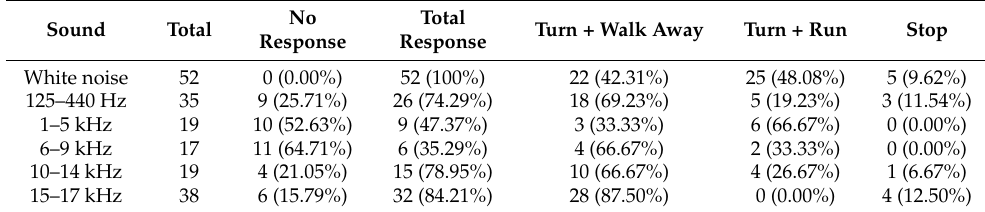
Table 1. Frequency bands and number of repetitions in trial